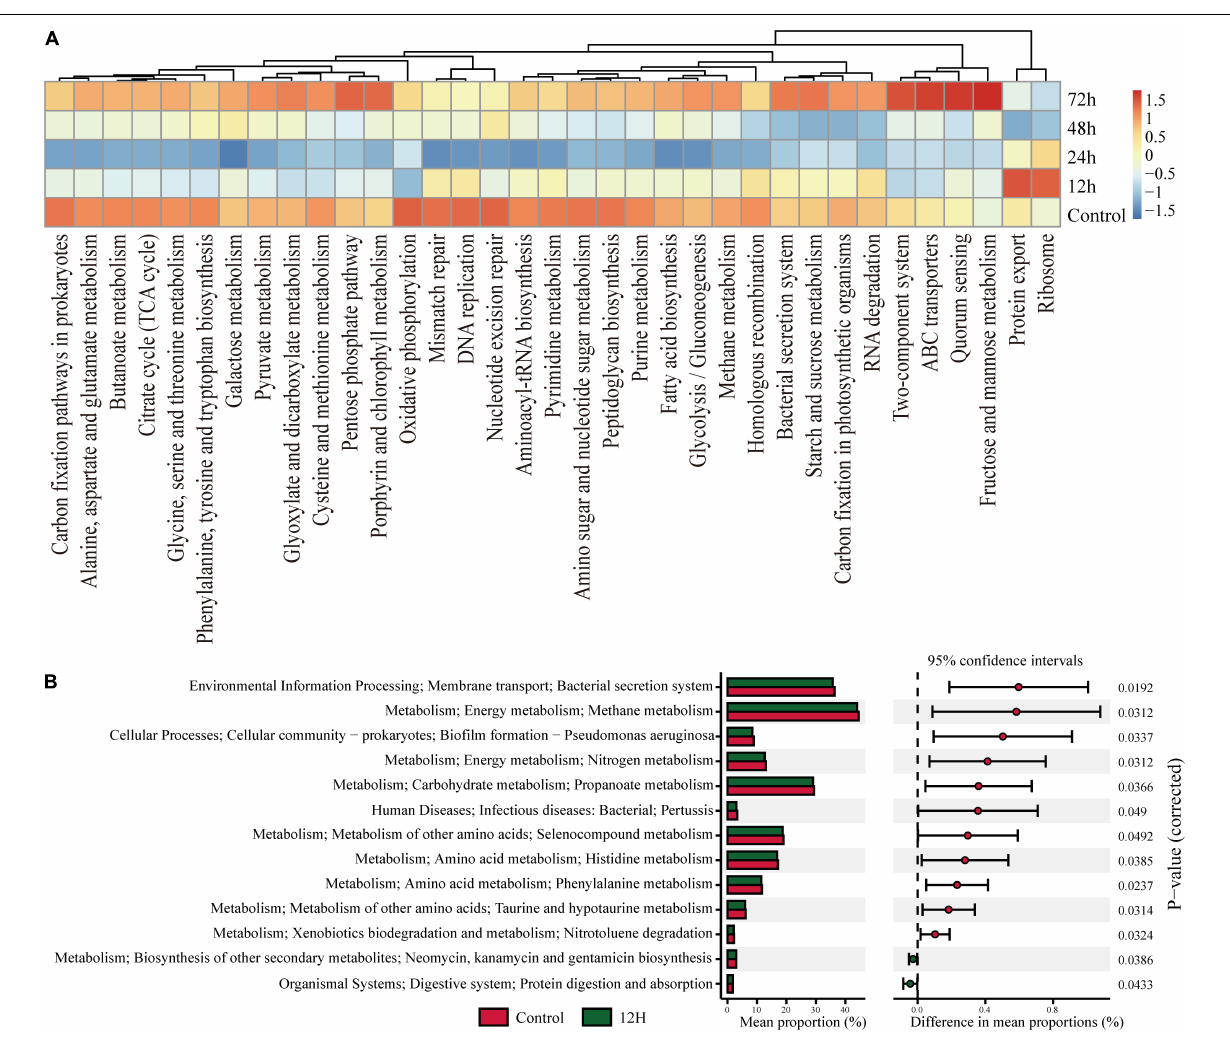
FIGURE 5 | KEGG Orthology (KO) pathway enrichment among experimental groups. Q -value is used as a corrected P -value ranging from 0.0 to 1.0. Low Q -values indicate greater intensity (enrichment). (A) Heat map showed abundances of KO labels. The results were picked with minimum value of the BCR. (B) Prediction of KEGG pathways between control and treatment groups as detected by STAMP software. Differential KEGG pathways between the control group and the treatment group after infection at 12 h. For each comparison, the mean proportion of predicted KEGG pathways (left) and difference in mean proportions (right) were